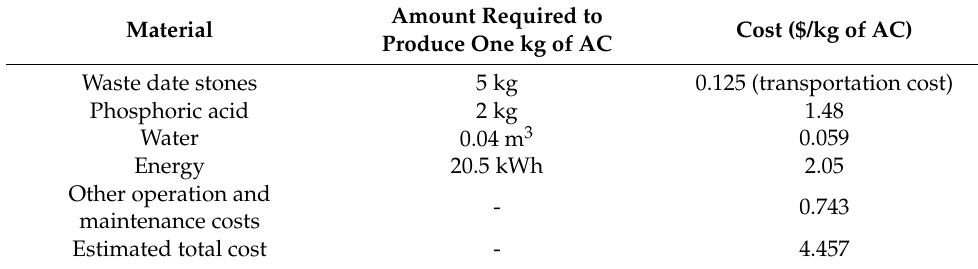
Table 9. Estimated production cost per kg of date-stone-activated